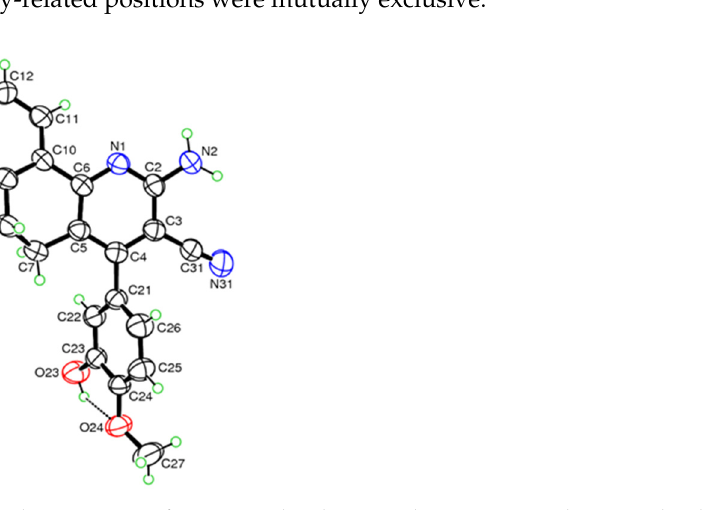
Table 1. In silico evaluation of physicochemical properties of compounds 4—15.